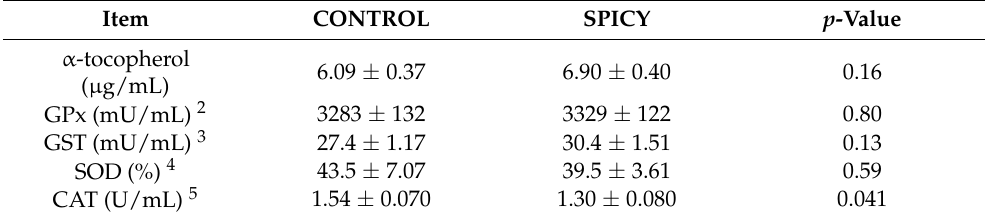
Table 6. Effects of experimental diets on plasma alpha-tocopherol and antioxidant activity of enzymes in broilers at 21 days of age 1 .